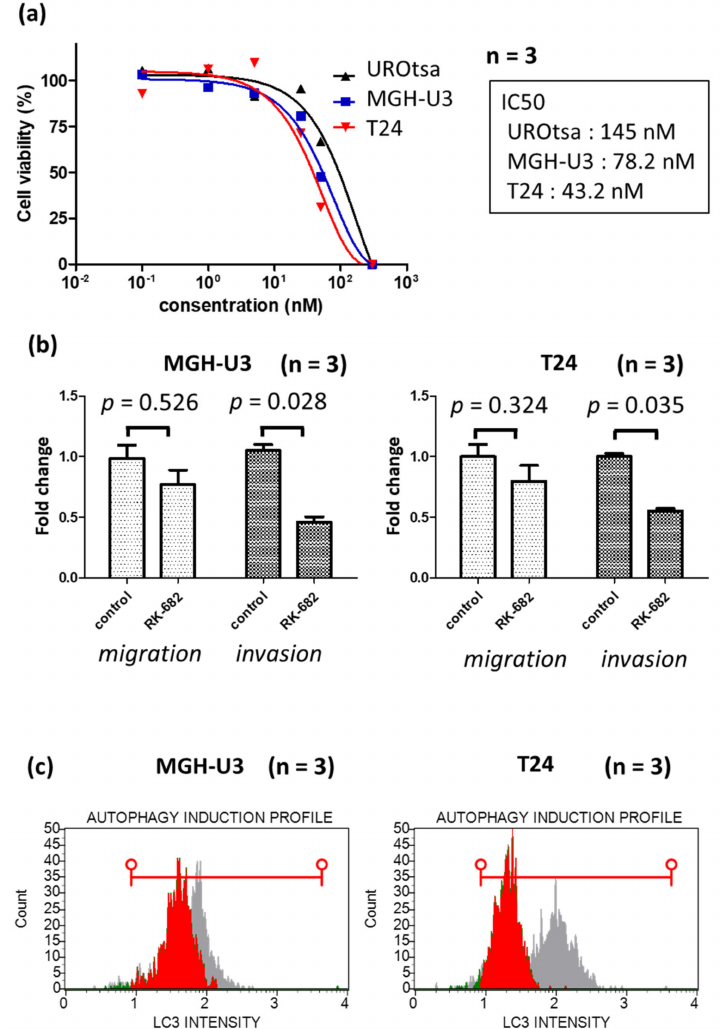
Figure 3. ( a ) Treatment with the multi enzyme inhibitor RK-682 inhibited cell proliferation in MGH-U3, T24 cells and UROtsa. Cells were incubated in serum-free media for 24 h and treated with di ff erent concentrations of RK-682 for a further 48 h. The number of viable cells was measured by an MTS assay and expressed as a percentage of viable cells; ( b ) e ff ect of RK-682 on MGH-U3 and T24 cells. RK-682 treatment resulted in a significant inhibition of MGH-U3 and T24 cell invasion ( p < 0.05); ( c ) 48 h treatment with heparanase inhibitor RK-682 inhibited cell autophagy in MGH-U3 and T24 cells. The red horizontal line shows the range of LC3 intensity after KR-682